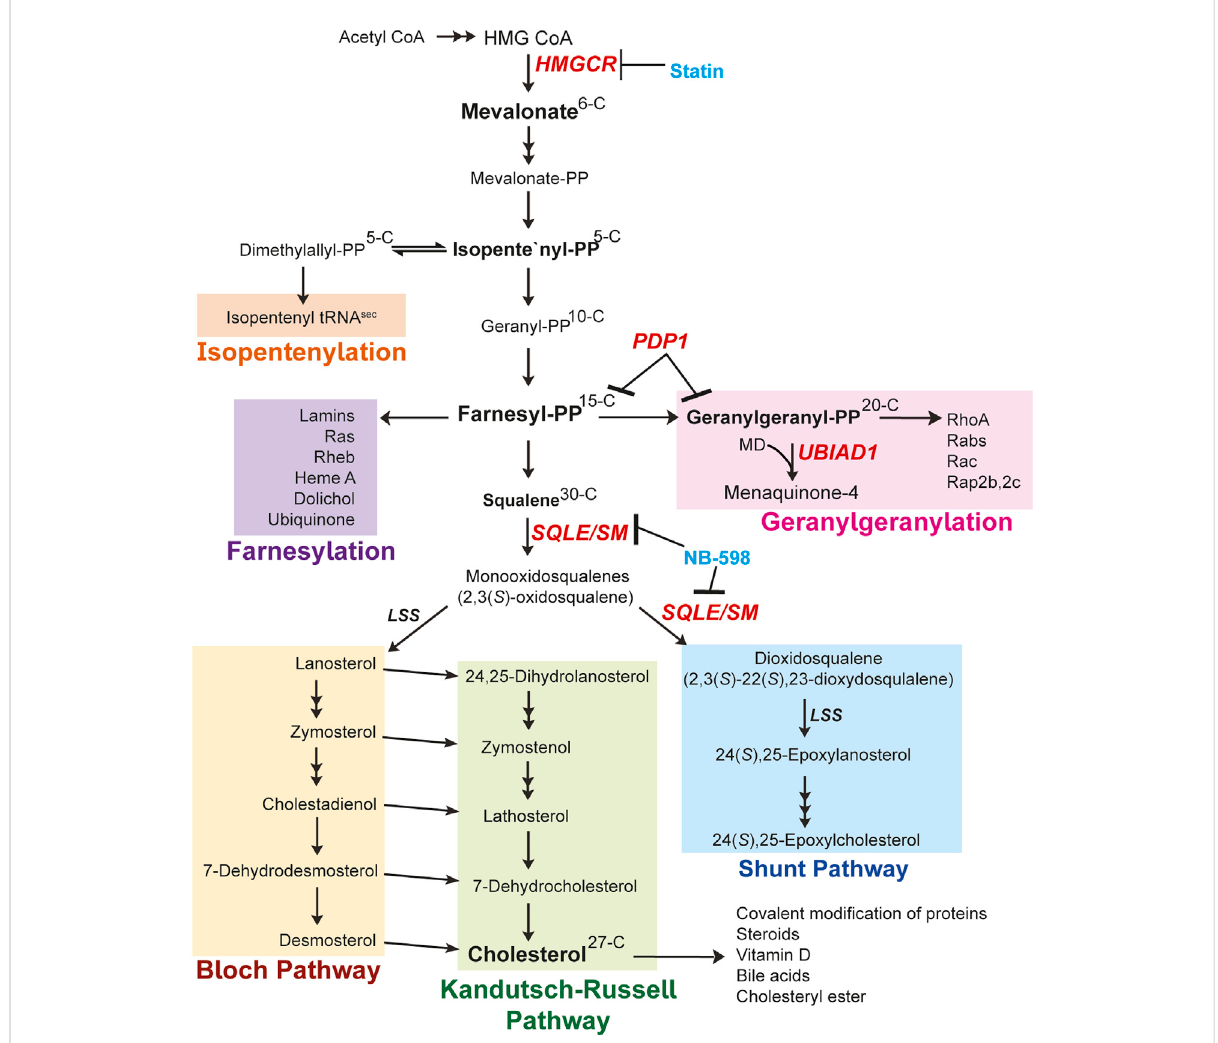
Mevalonatepathway(BrownandGoldstein,1980;BoriniEtichettietal.,2020).Explanationofthepathwayisdescribedinthemaintext.Changes in carbon numbers are denoted by the right side of the molecules. The enzymes focused on in this review are indicated in red. The known inhibitors for enzymes are denoted in blue. Abbreviations: HMGCR, 3-hydroxy-3-methylglutaryl (HMG) Coenzyme A reductase; PP, pyrophosphate; MD, menadione; UBIAD1, UbiA prenyltransferase domain-containing protein-1; SQLE/SM, squalene epoxidase also called SM; LSS, lanosterol synthase; PDP1, type I polyisoprenoid diphosphate phosphatase 1 also called